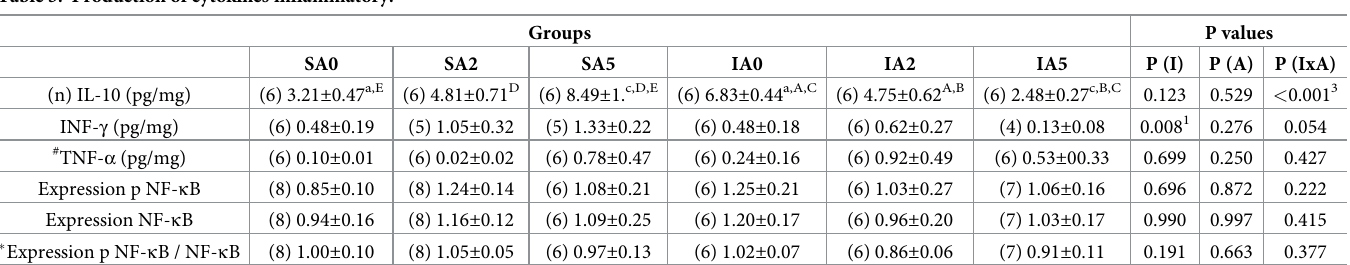
Table 5. Production of cytokines